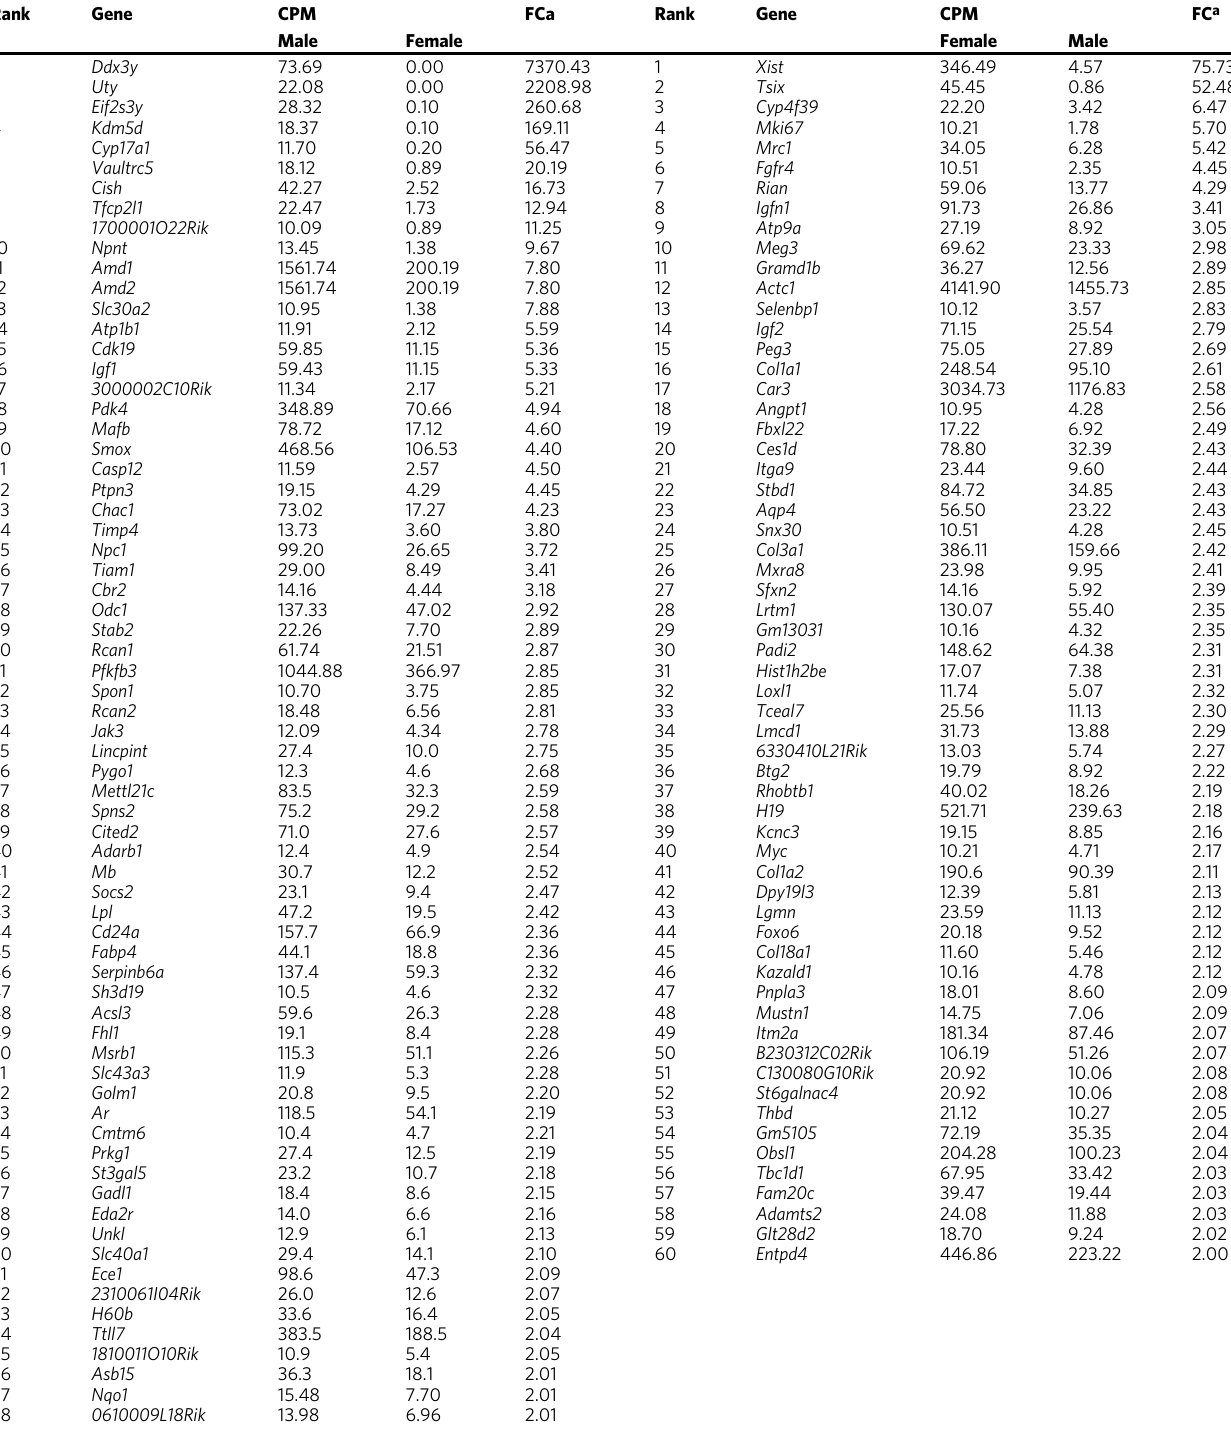
Table 1 List of male-enriched (left) and female-enriched (right)